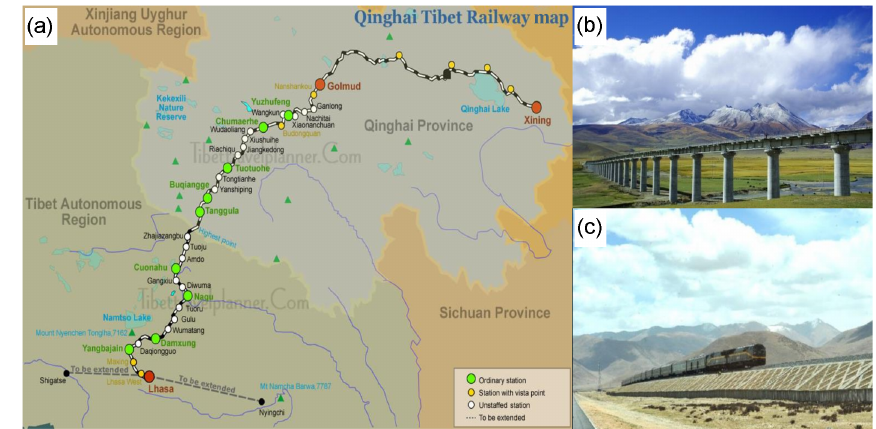
Figure 1. (a) Distribution map of main stations along Qinghai–Tibet Railway. Red circle is the starting station, green circle is the viewing platform station, yellow circle is the ordinary station, and white circle is the unattended station. The charts (b) and (c) show that the Qinghai– Tibet Railway has been built and opened to traffic.